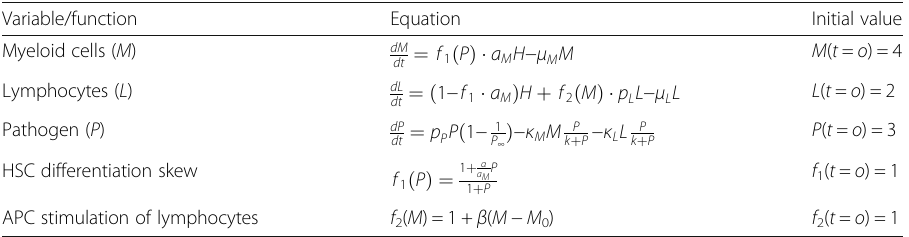
Table 1 Equations for model V1. Parameter definitions and values: HSC population, H = 0.5; homeostasis probability of HSC differentiation into a myeloid cell, a M = 0.2; myeloid death rate, p μ μ M = 0.025; lymphocyte proliferation rate, L =0.2; lymphocyte death rate, L = 0. 4; pathogen proliferation rate, p P values vary. Pathogen killing rate by myeloid cells, κ M = 0.6; pathogen killing rate by lymphocytes, κ L = 1; HSC skew regulator, α = 0.8; rate of APC stimulation of lymphocytes, β = 0.2. See Additional file 1 for a concise summary and explanation of the equations and parameters for all models presented in this